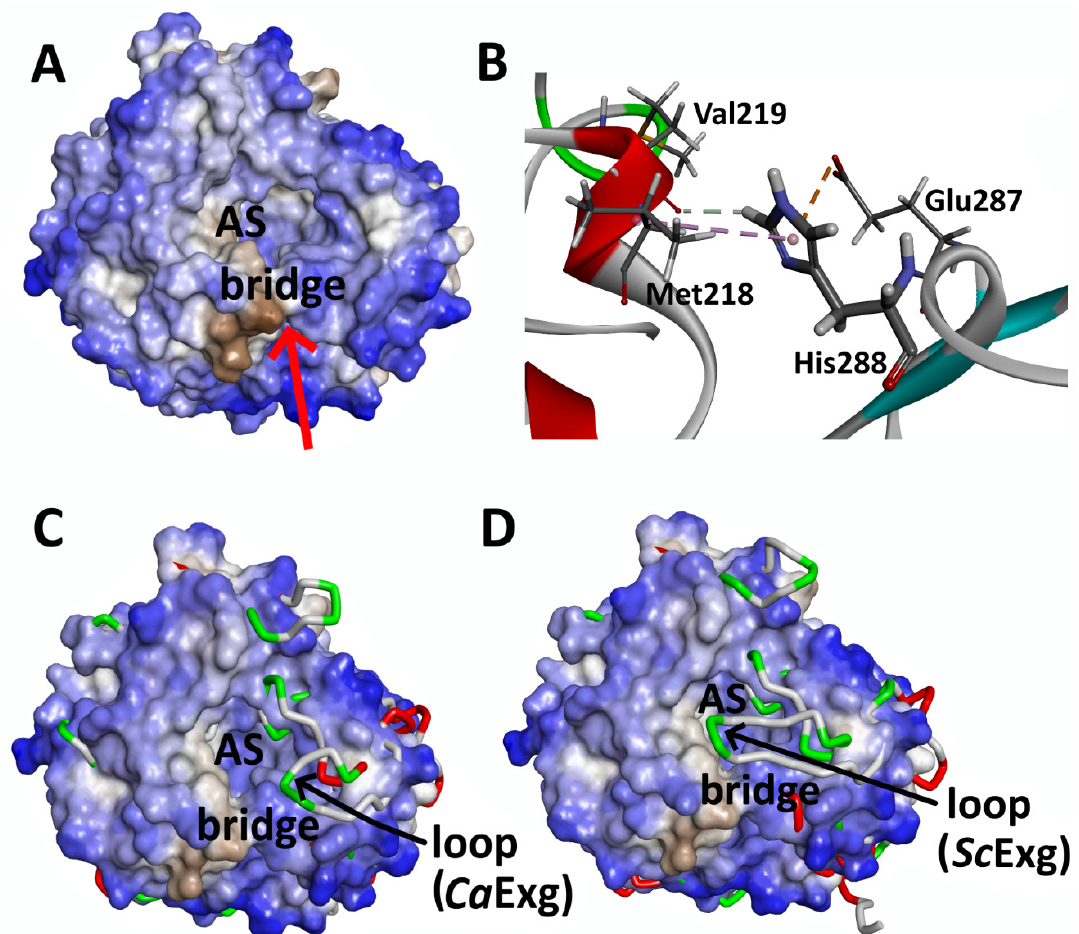
Figure 5. The structural similarity of An Rut, Ca Exg, and Sc Exg in the area of deep valley leading to the protein active site (AS). ( A ) Surface model of An Rut protein colored by hydrophobicity with a deep bridged valley indicated by a red arrow; ( B ) View of the bridge residues of An Rut, which span the valley via non-covalent interactions caused by the presence of His288 (His288-Val219 via π -alkyl, His288-Met218 via van der Waals, and His288-Glu287 via π -anion interactions); ( C ) Hydrophobic surface model An Rut superimposed into Ca Exg tube model revealing the existence of a flexible loop in Ca Exg (Glu314-Ile323) over the valley; ( D ) Hydrophobic surface model of An Rut superimposed into Sc Exg tube model revealing the existence of a large loop in Sc Exg (Gly357-Cys372) over the valley.